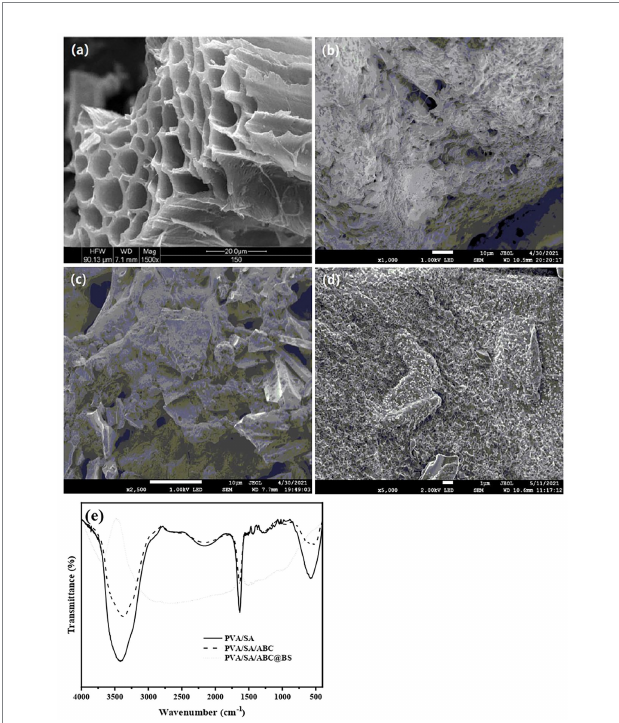
FIGURE 2 The SEM images of (A) ABC, (B) PVA/SA, (C) PVA/SA/ABC, (D) PVA/SA/ ABC@BS and the FTIR spectra of different gel beads (E)